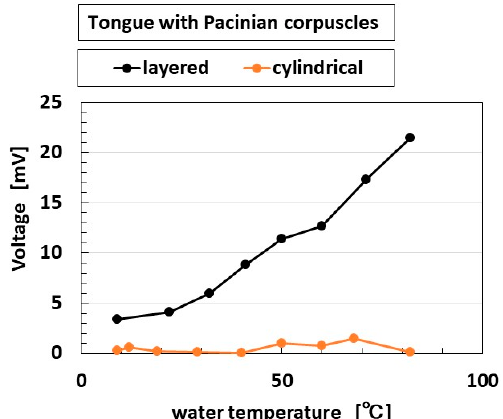
Figure 12. Experimental results of built-in voltage response to thermal variations of water.